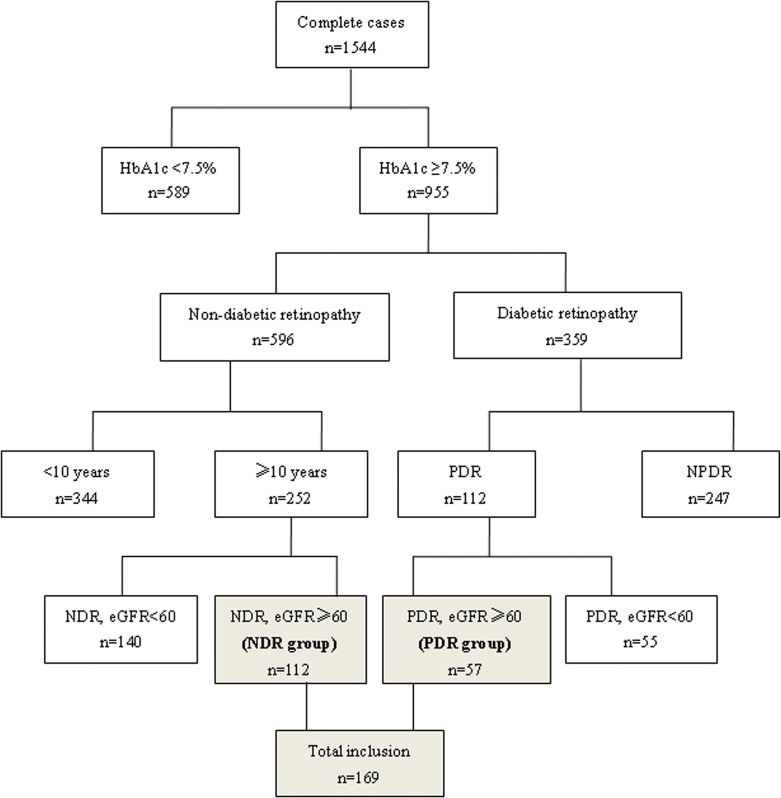
Inclusion and exclusion flow chart.